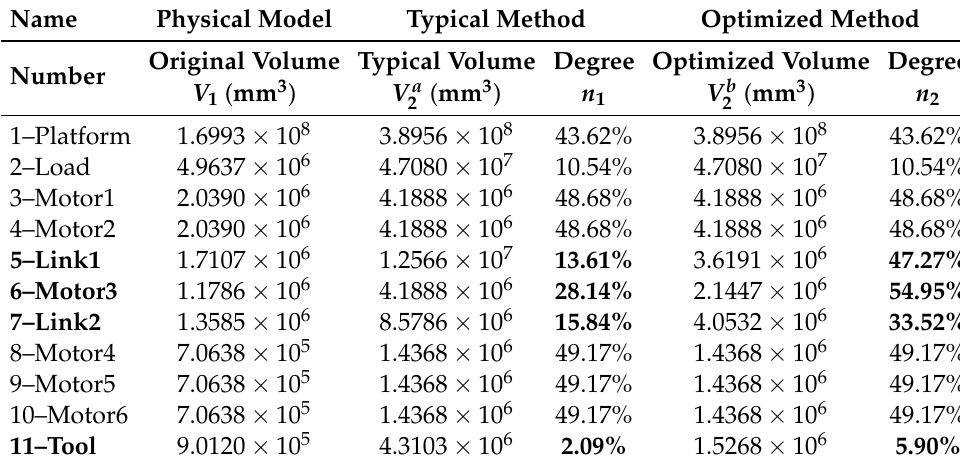
Table 2. Approximation degree of each